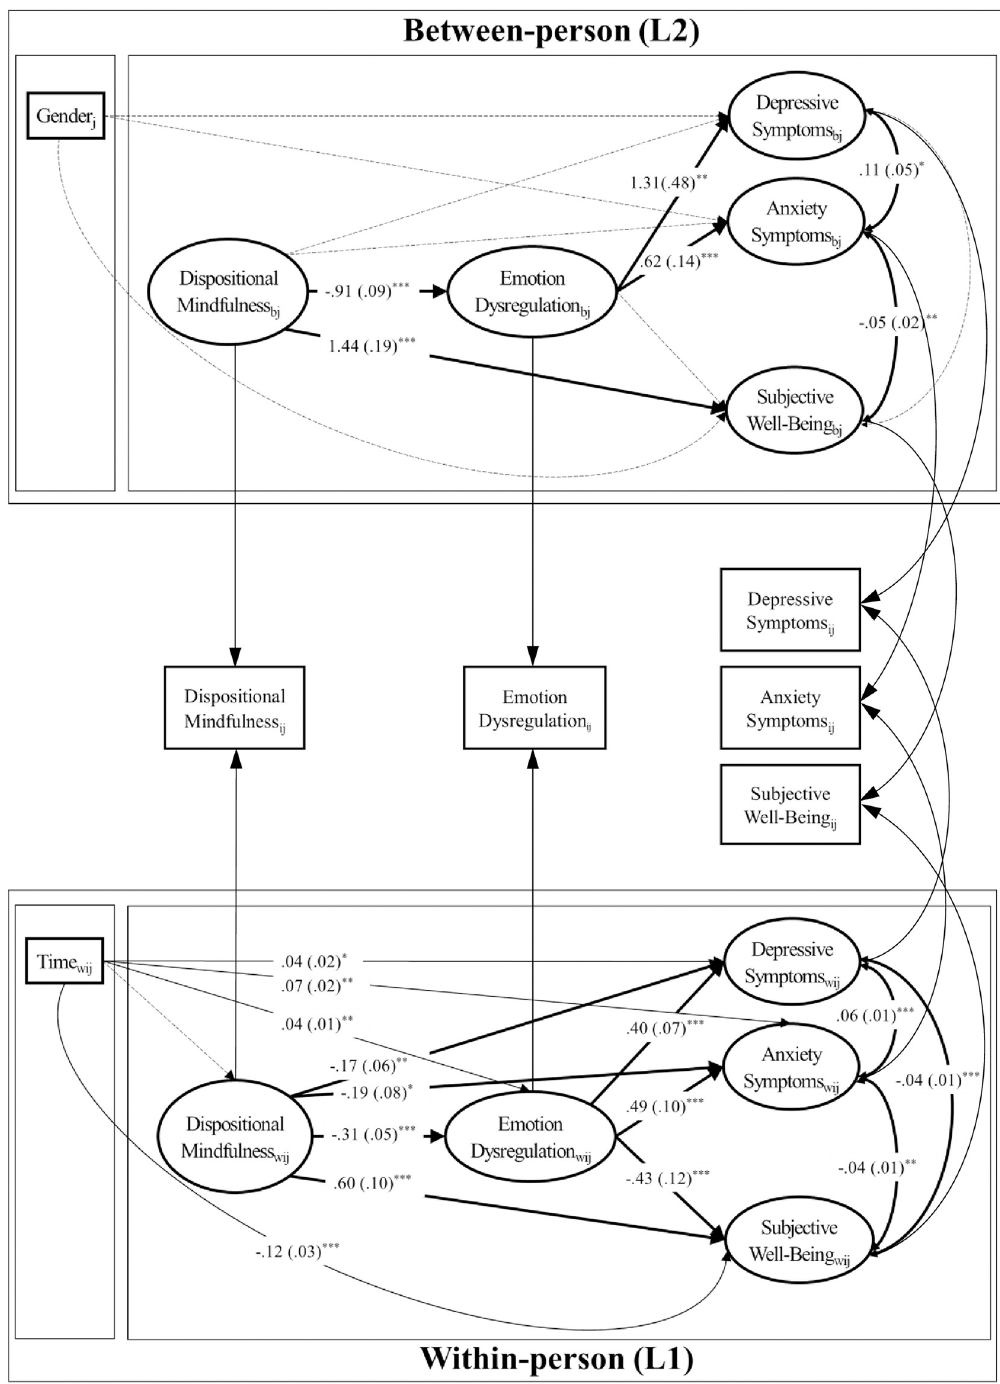
Fig 1. Multilevel mediation model of dispositional mindfulness, emotion dysregulation, and mental health outcomes. � p = / < .05, �� p = / < .01, ��� p = / < .001. Unstandardized parameter estimates and standard errors in parentheses are presented. For simplicity, the random slope of depressive symptoms regressed on dispositional mindfulness is not depicted.